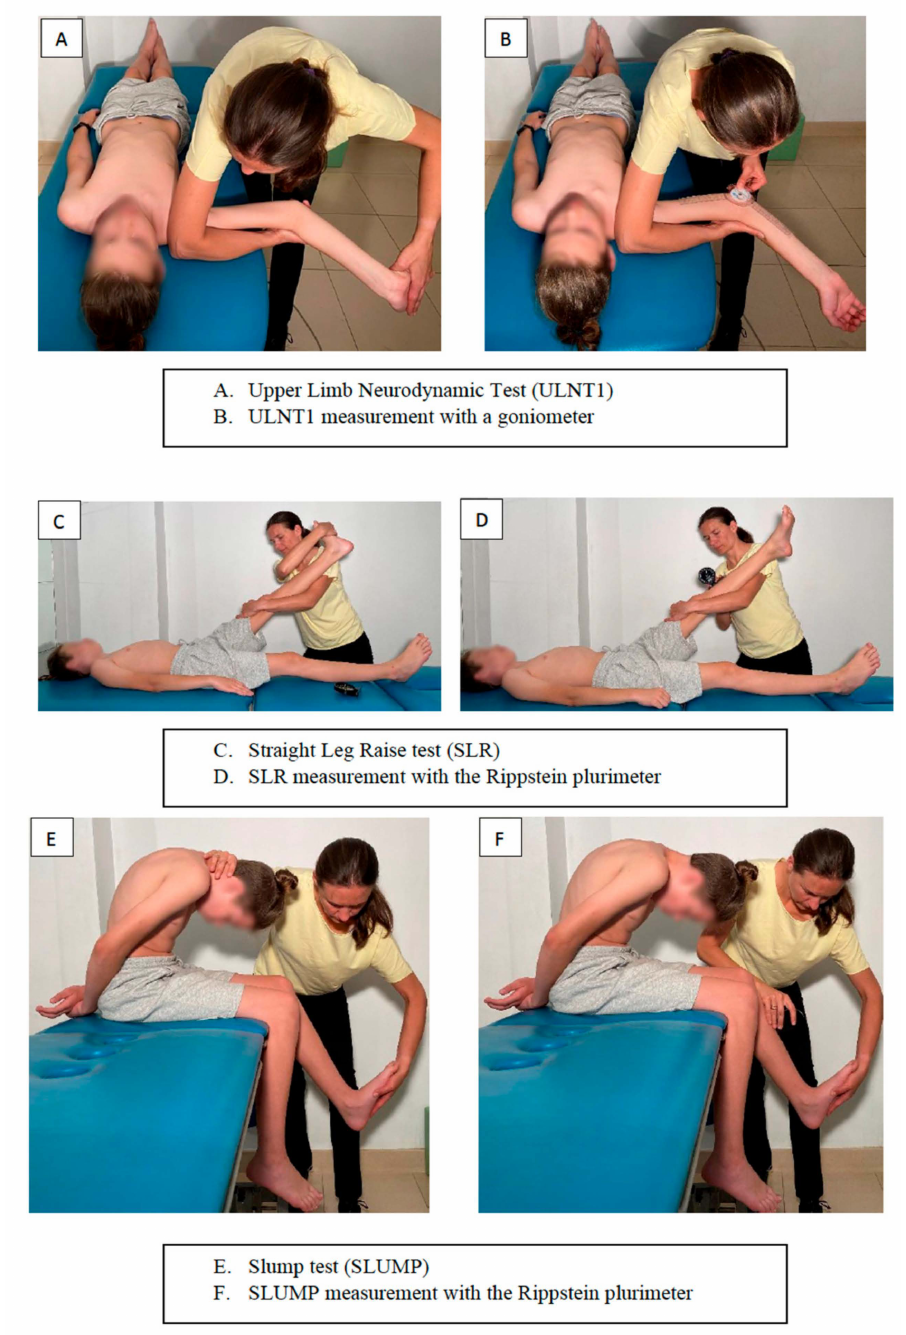
Figure 2. Neurodynamic tests used in this study: ( A , B ) ULNT1, ( C , D ) SLR, ( E , F )